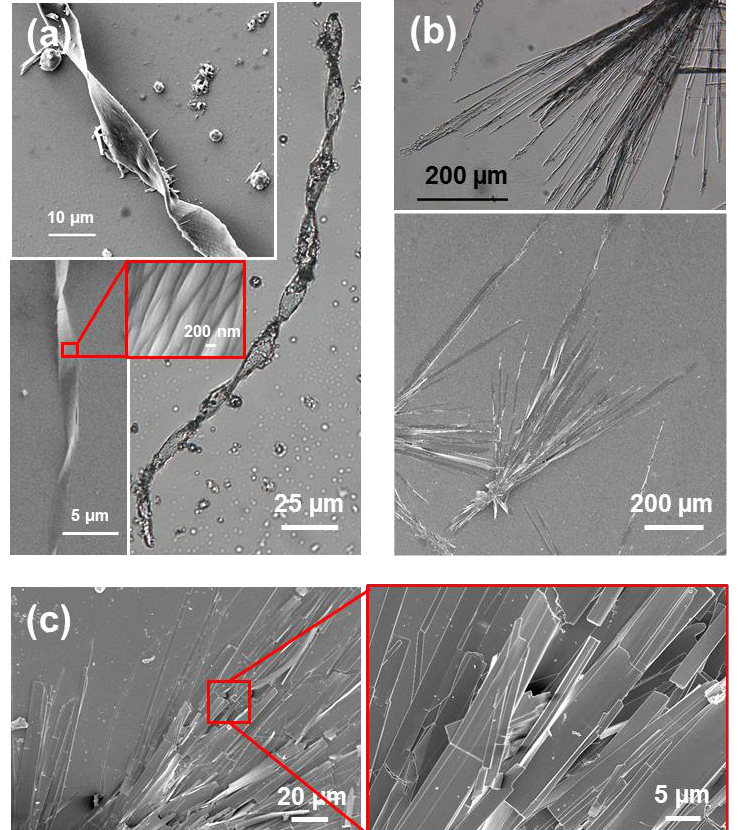
Figure 5. SEM images of the structures obtained from FFF solutions in ( a ) 1:99 HFIP:water (0.05 mg/mL), ( b ) 1:9 HFIP:water (0.5 mg/mL), and ( c ) 4:6 HFIP:water (2 mg/mL). Substitution of water by more volatile MeOH in very dilute peptide solutions (0.05 g / mL)